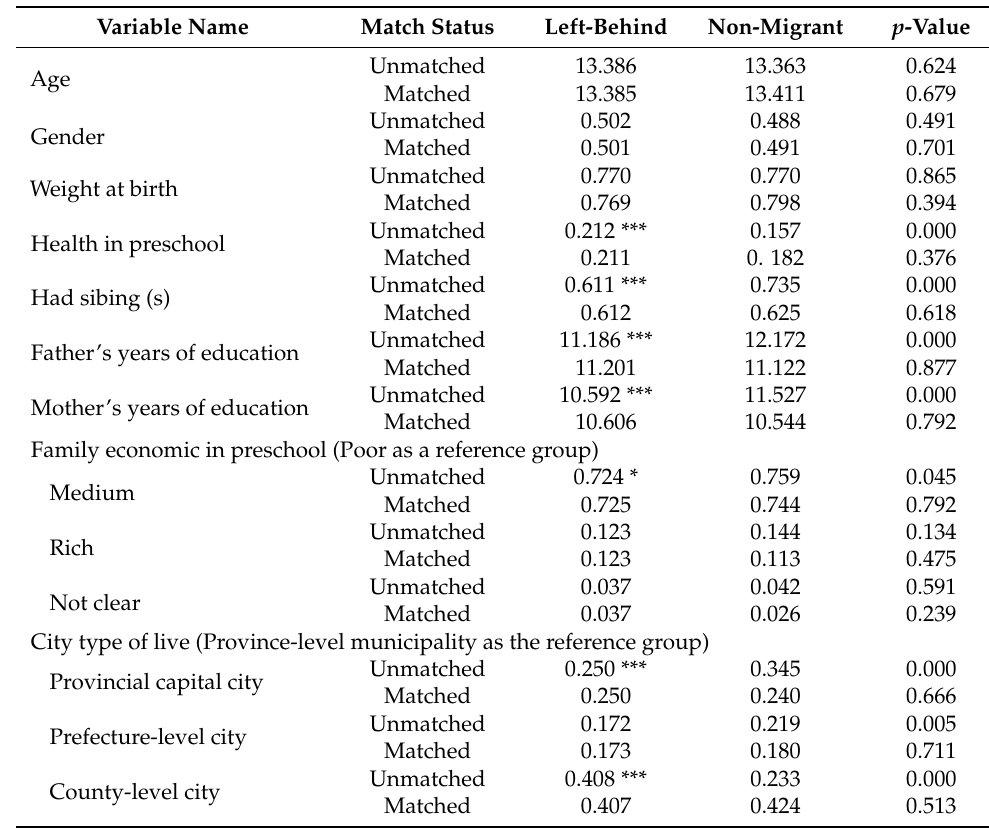
Table A4. Balance test